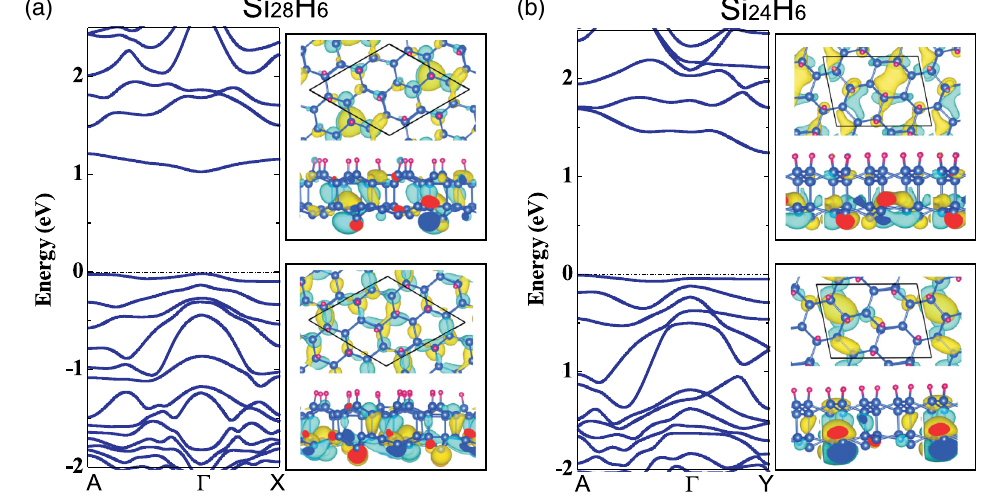
FIG. 6. The calculated band structures of single-sided (a) Si 28 H 6 and (b) Si 24 H 6 . The wave functions of VBM (bottom figure) and CBM (top figure) at the Γ point for Si 28 H 6 and at the Y point for Si 24 H 6 are also plotted here. The Fermi level is set to